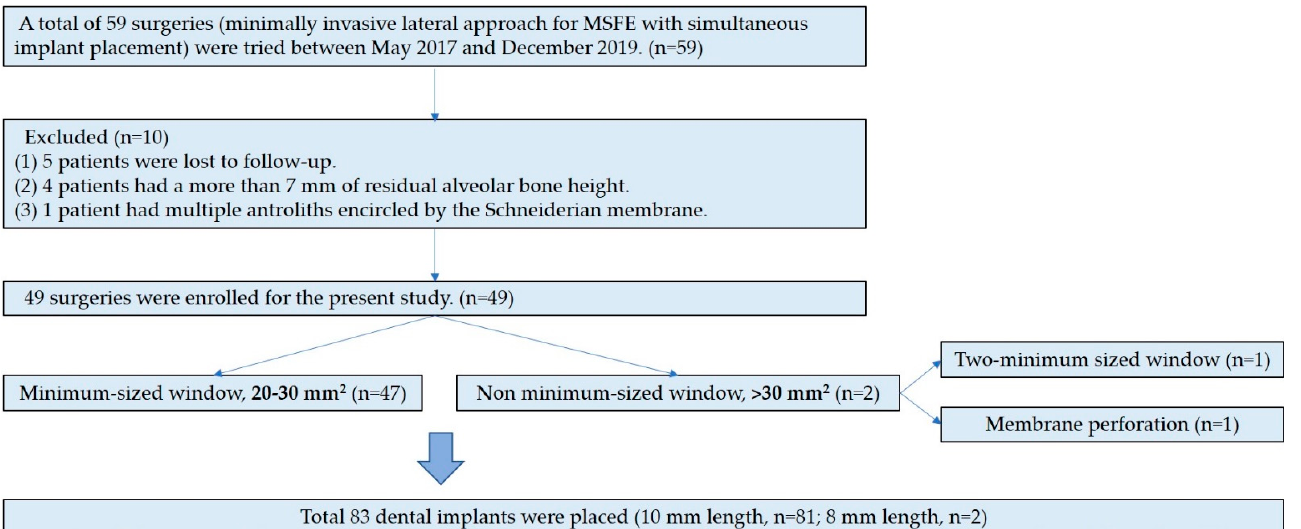
Figure 1. Flow diagram of patient participation.